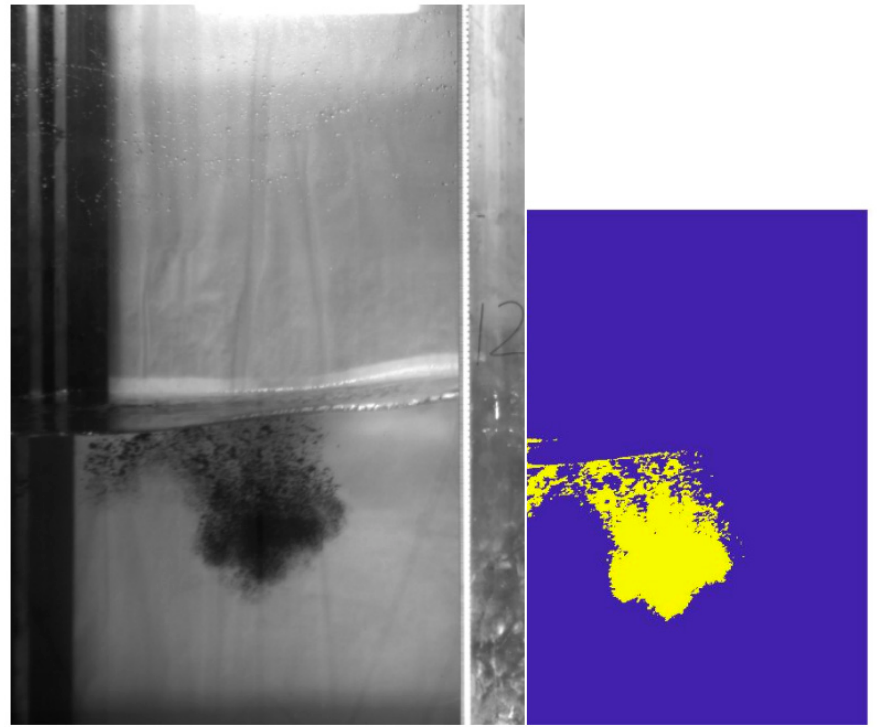
Figure 12. Spilled oil in the observation area without breaking wave.